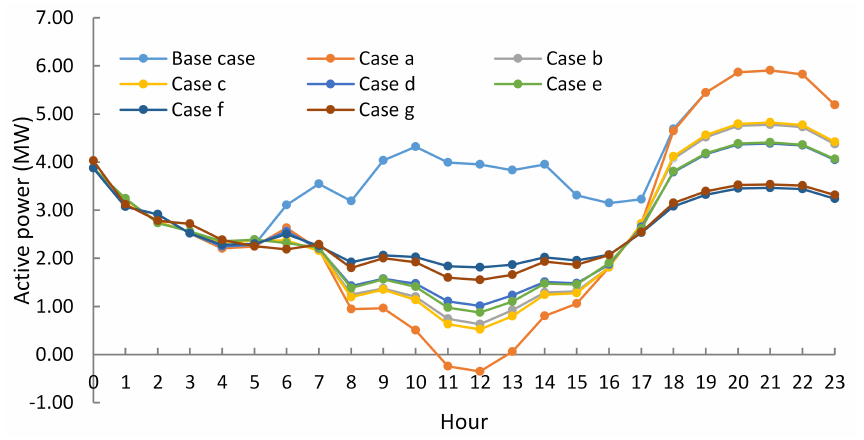
Figure 6. Slack bus generation for all cases.